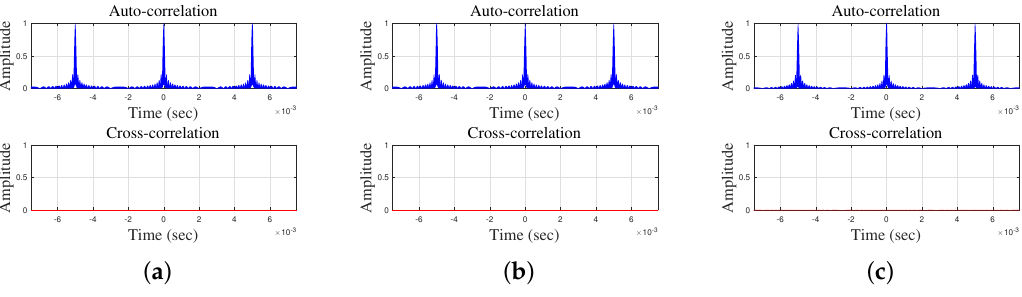
Figure 3. Comparisons of auto-correlations and cross-correlations of three waveforms for the proposed method: ( a ) waveforms 1 and 2; ( b ) waveforms 1 and 3; and ( c ) Waveforms 2 and